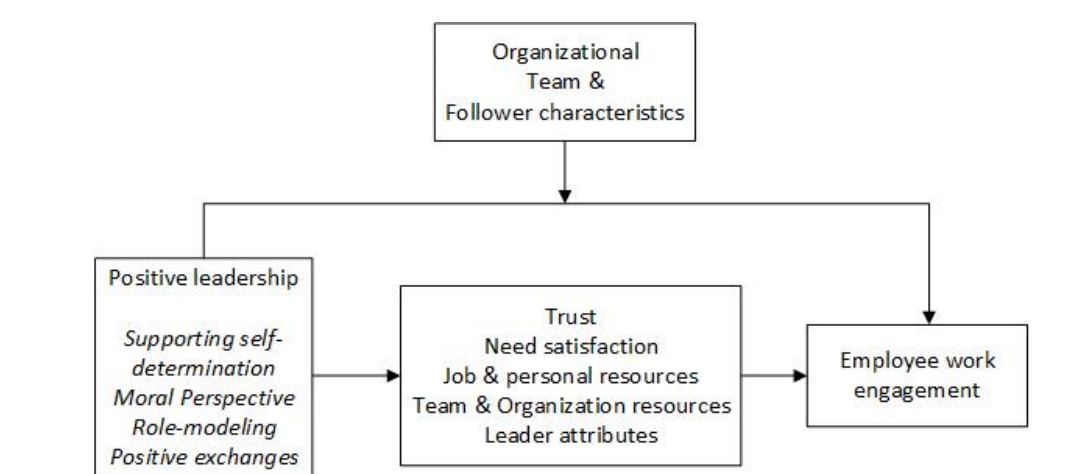
Figure 1. Empirical research model based on the mediating and moderating mechanisms from studies in the meta-analysis. The three behaviours of positive leadership styles in italics are based on a theoretical comparison. The overarching categories over mediators and moderators can be found in the middle squares, in the order of magnitude with regards to the amount of studies in each category. Resources can be further divided into job resources and personal resources.